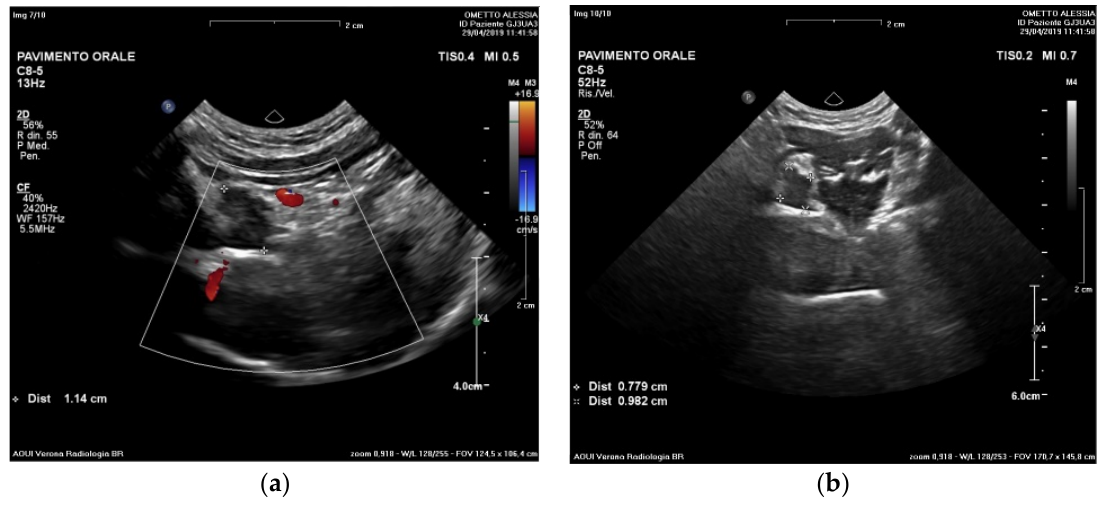
Figure 2. Ultrasound examination. Evaluation at different frequencies ( a ) and size ( b ) of the pseudocystic lesion. A hypodense lesion (11 × 8 mm) was observed.